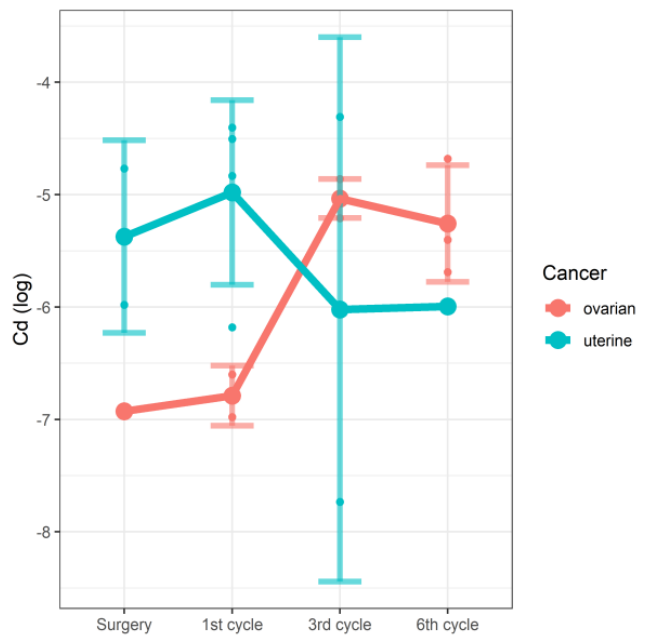
Figure 2. Changes in Cd concentrations (log) by the stage of therapy and the type of cancer. Table 4. The concentrations of Mg and Cd depending on the stage of therapy and the type of